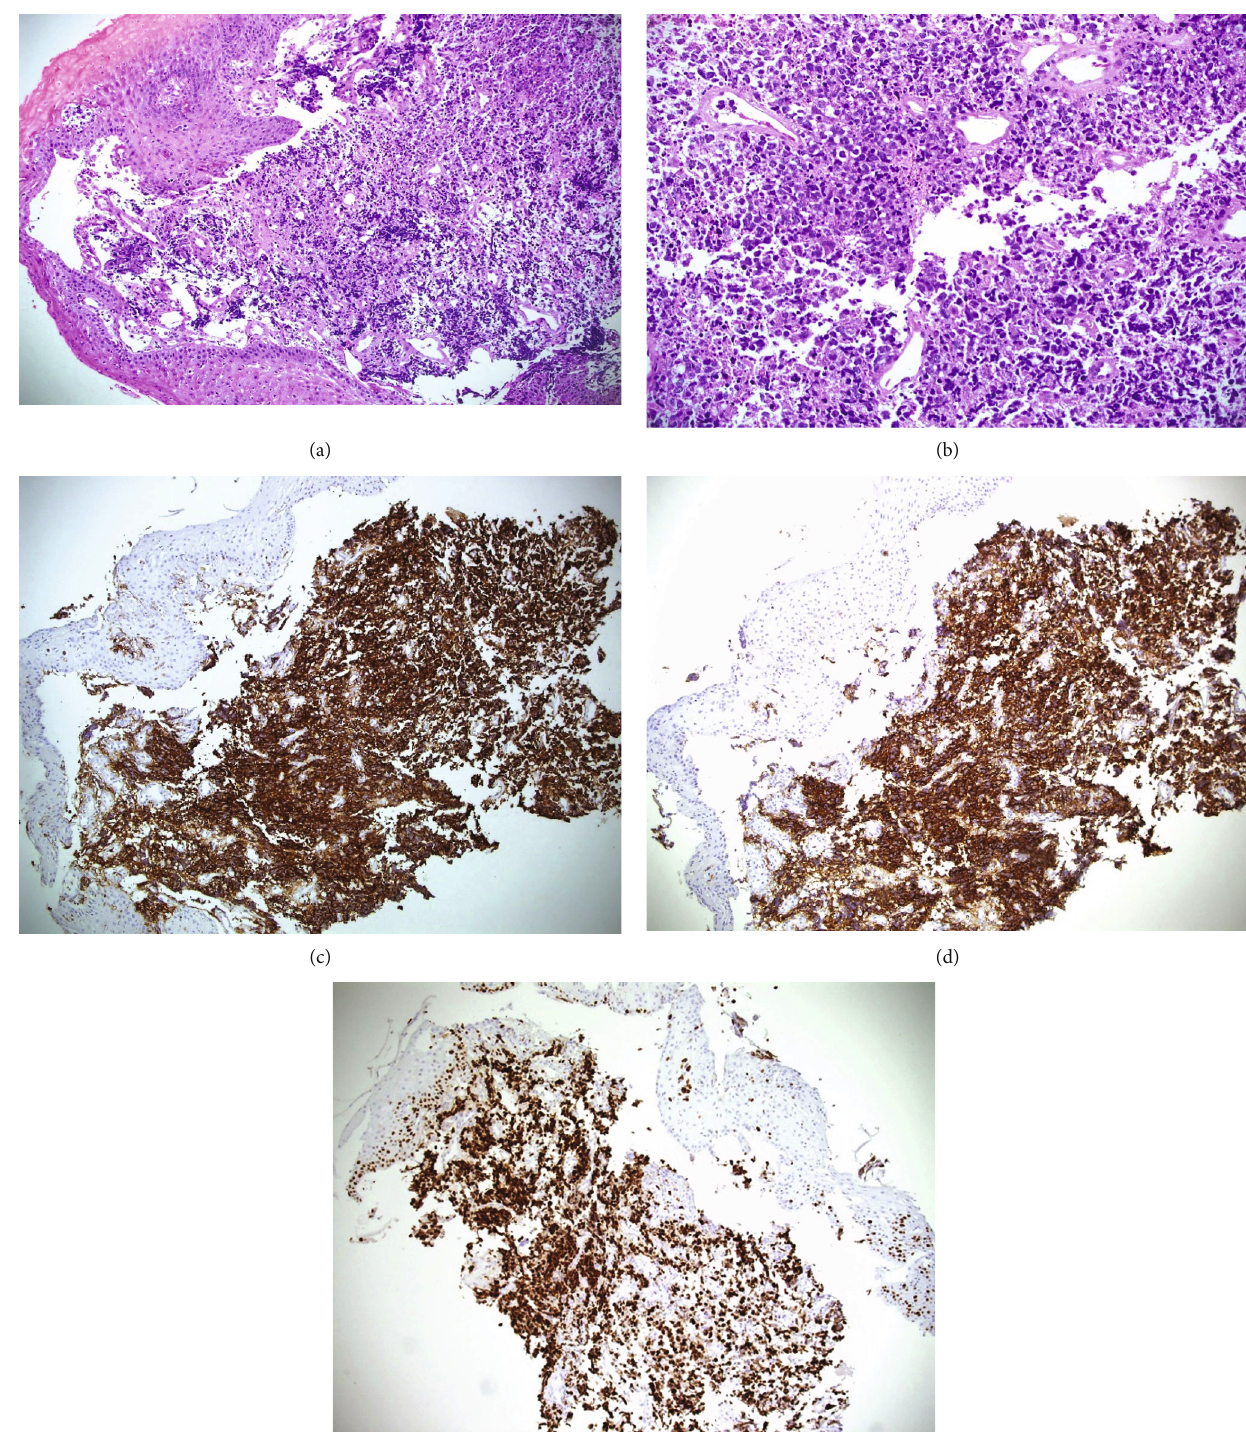
Figure 1: (a) Section of esophageal mass showing submucosal in fi ltration of lymphoma cells (hematoxylin and eosin, 200 × ). (b) Higher power of the same case; reveal large lymphoma cells surrounding some blood vessels (hematoxylin and eosin, 400 × ). (c) Di ff use large B- cell lymphoma expressing CD45 (immunohistochemistry stain, 200 × ). (d) Di ff use large B-cell lymphoma expressing CD20 (immunohistochemistry stain, 200 × ). (e) Di ff use large B-cell lymphoma with positive nuclear staining in 80% of tumor cells for KI-67 (immunohistochemistry stain, 200 ×